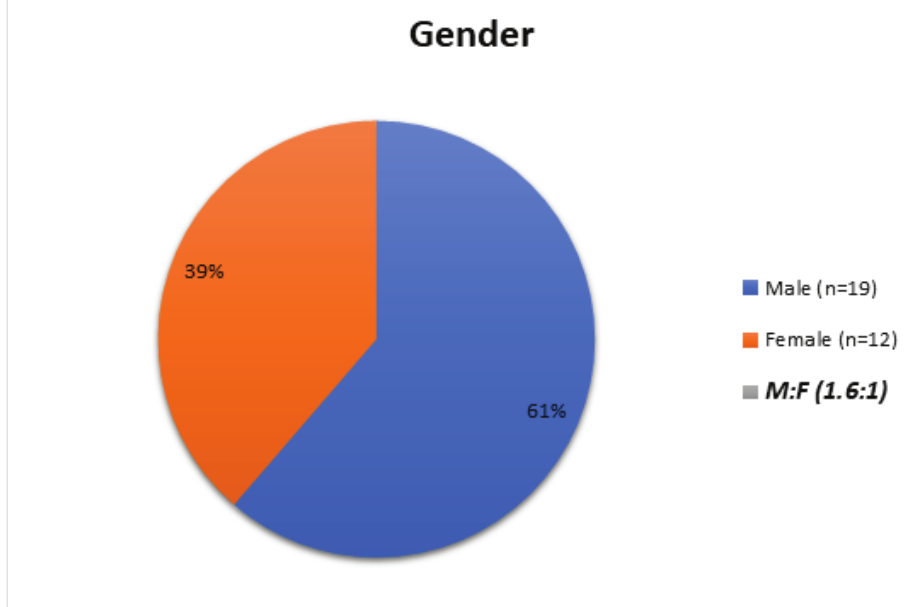
Figure 2: Gender distribution among study group ( n =